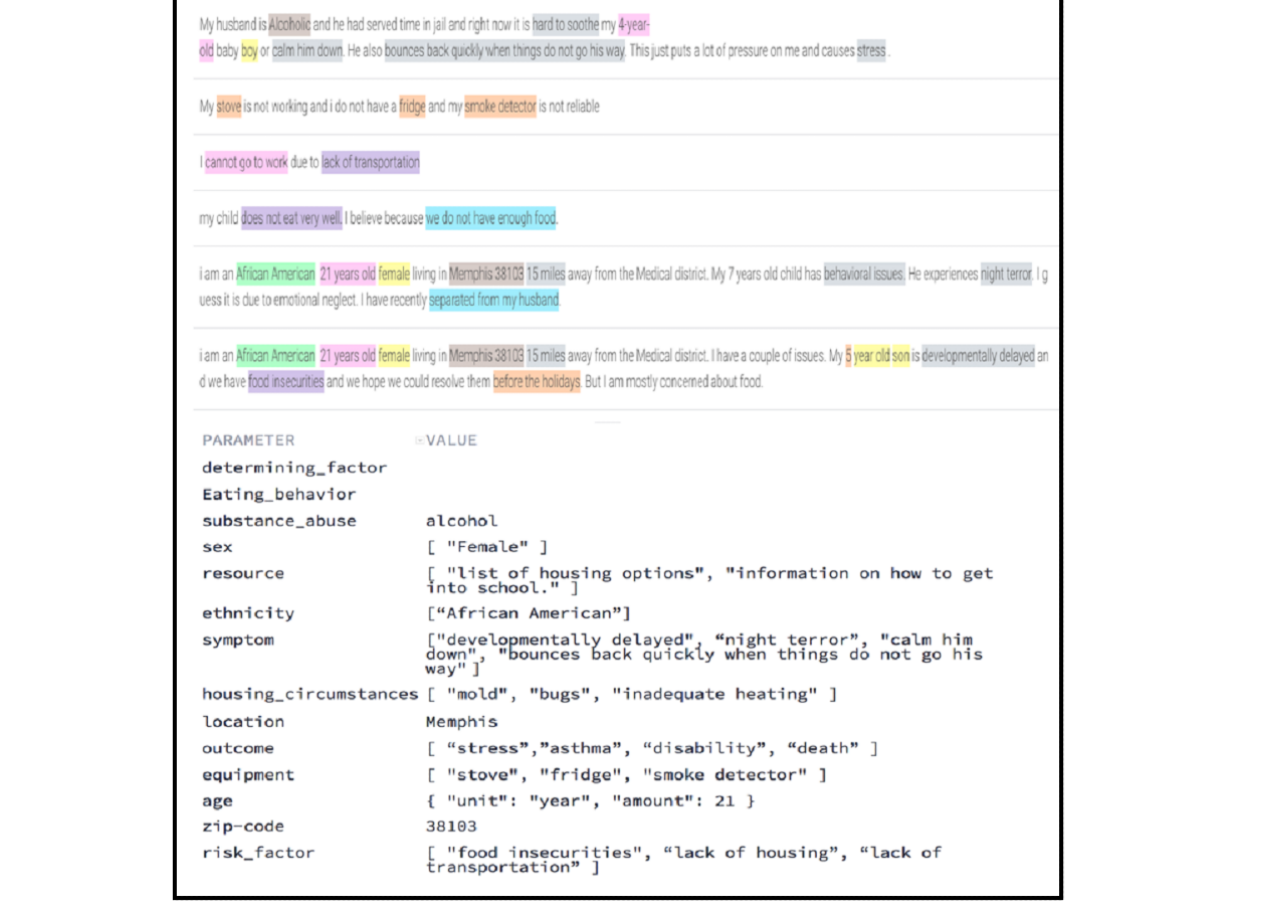
Figure 3. A sample training phrase and detected contextual parameters with entity types and